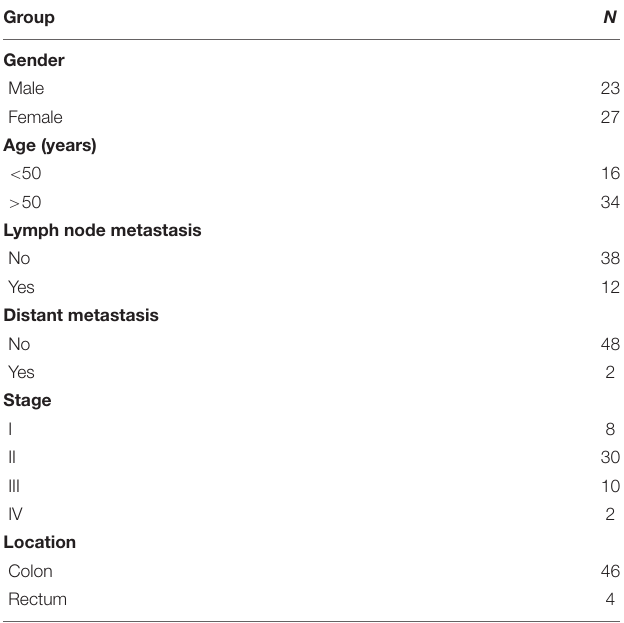
TABLE 1 | Clinicopathological characteristics of 50 CRC patients.